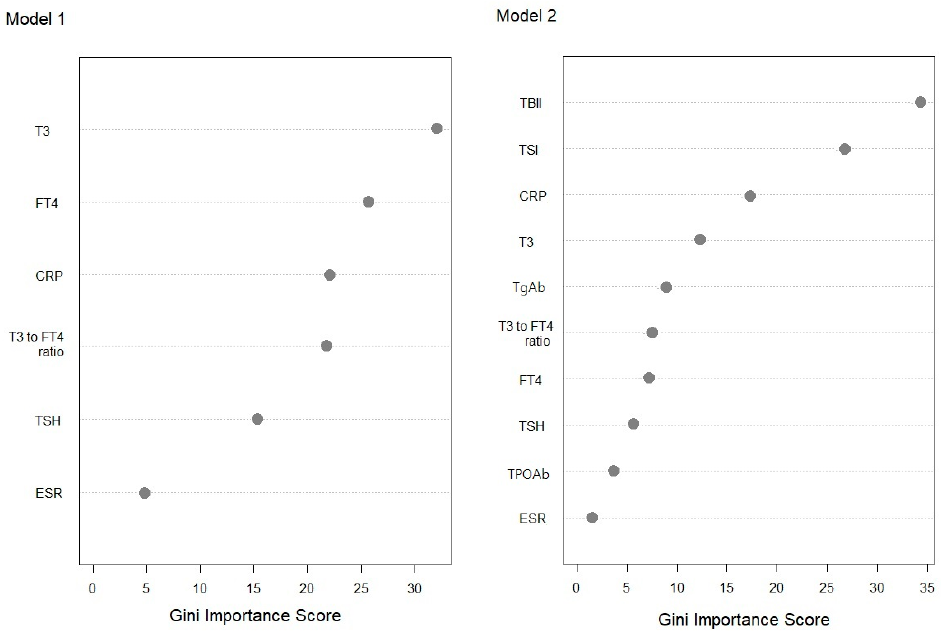
Figure 4. Variable importance plot for the random forest algorithm calculated using the impurity method for Model 1 and Model 2.